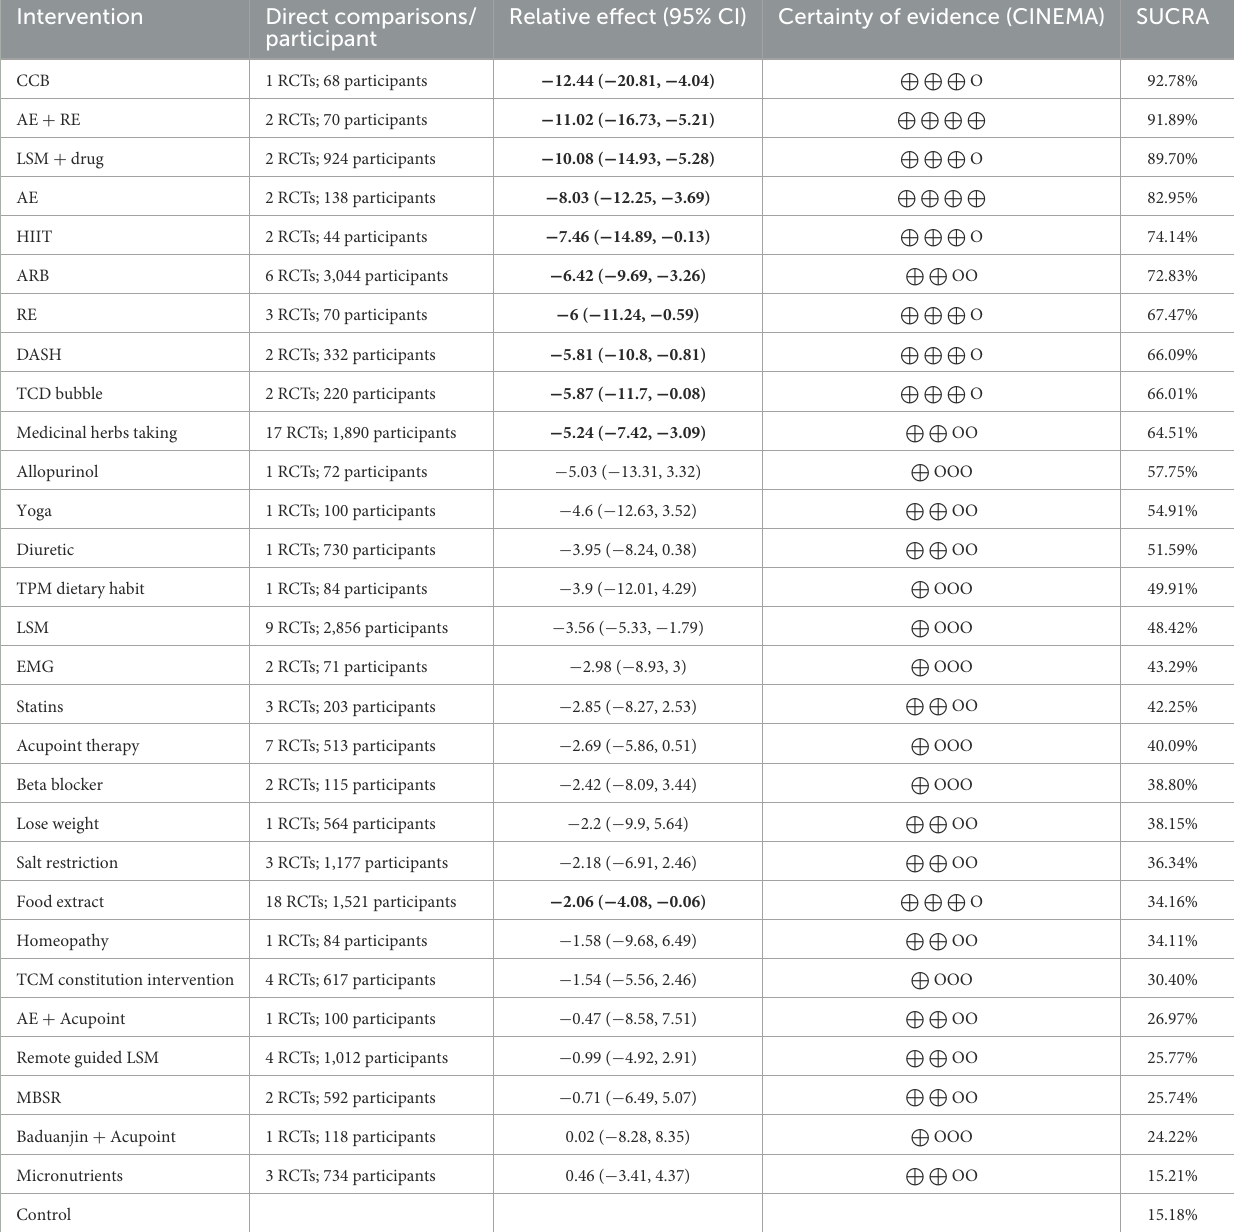
TABLE 2 Summary of findings on the efficacy of various interventions to reduce DBP. Intervention Direct comparisons/ Relative effect (95% CI) Certainty of evidence (CINEMA) participant